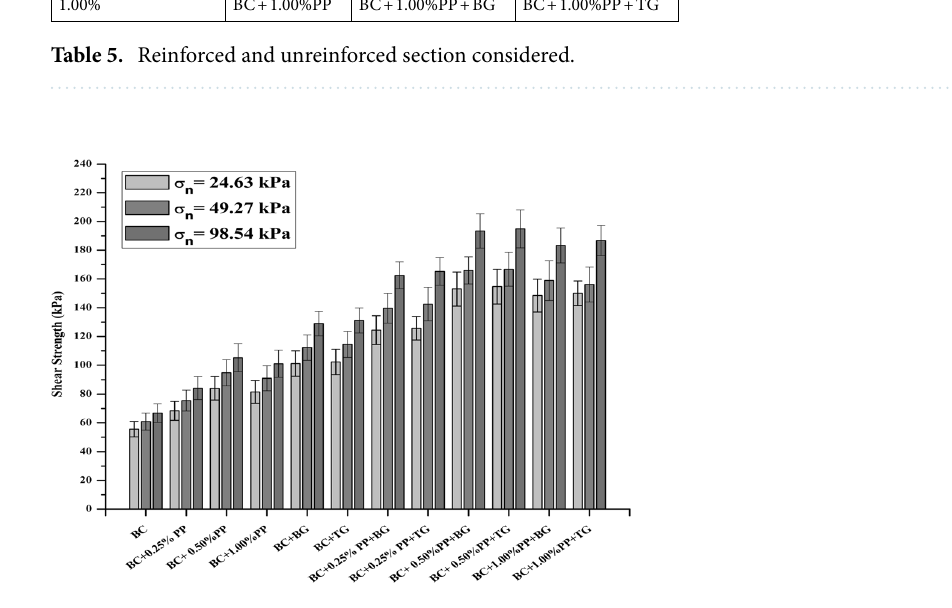
Figure 3. Shear strength of reinforced and unreinforced expansive